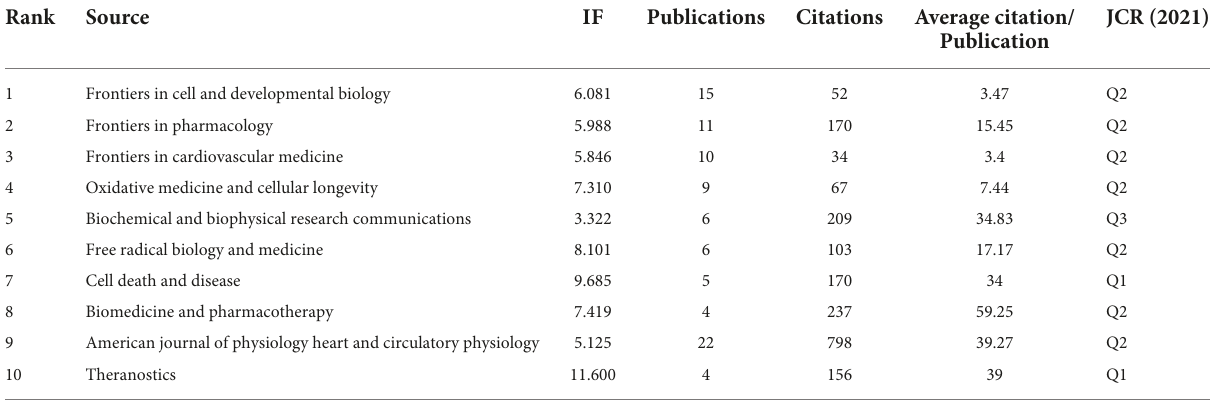
FIGURE4 Distributions of authors.